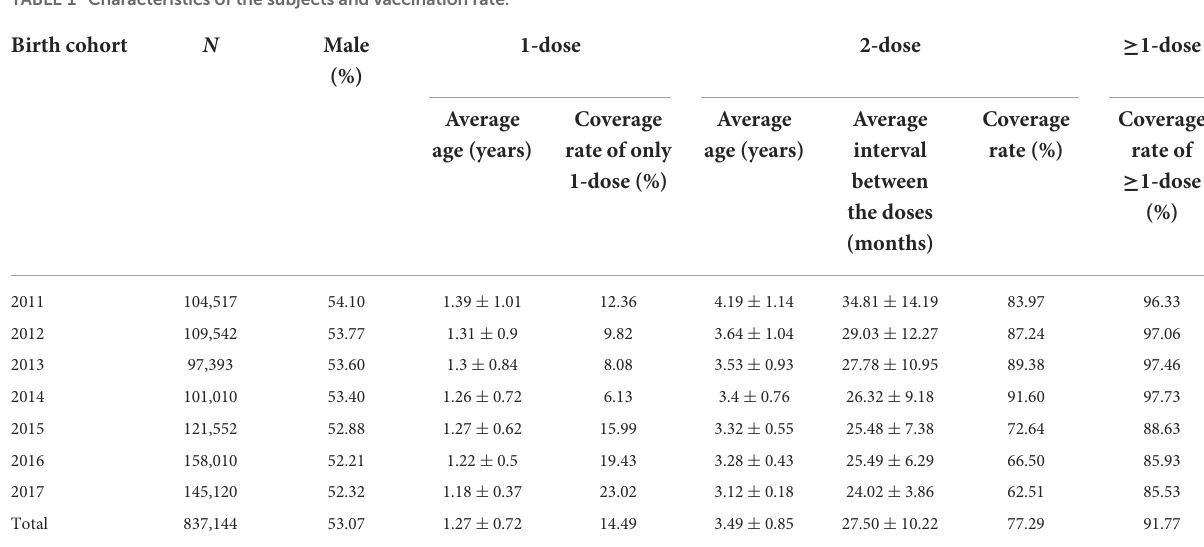
TABLE 1 Characteristics of the subjects and vaccination rate. Birth cohort N Male